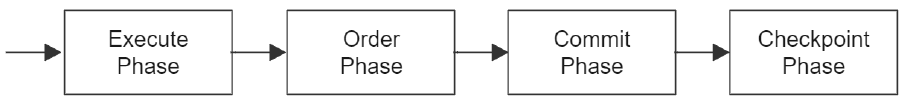
Figure 3. Execute and order in parallel transaction processing